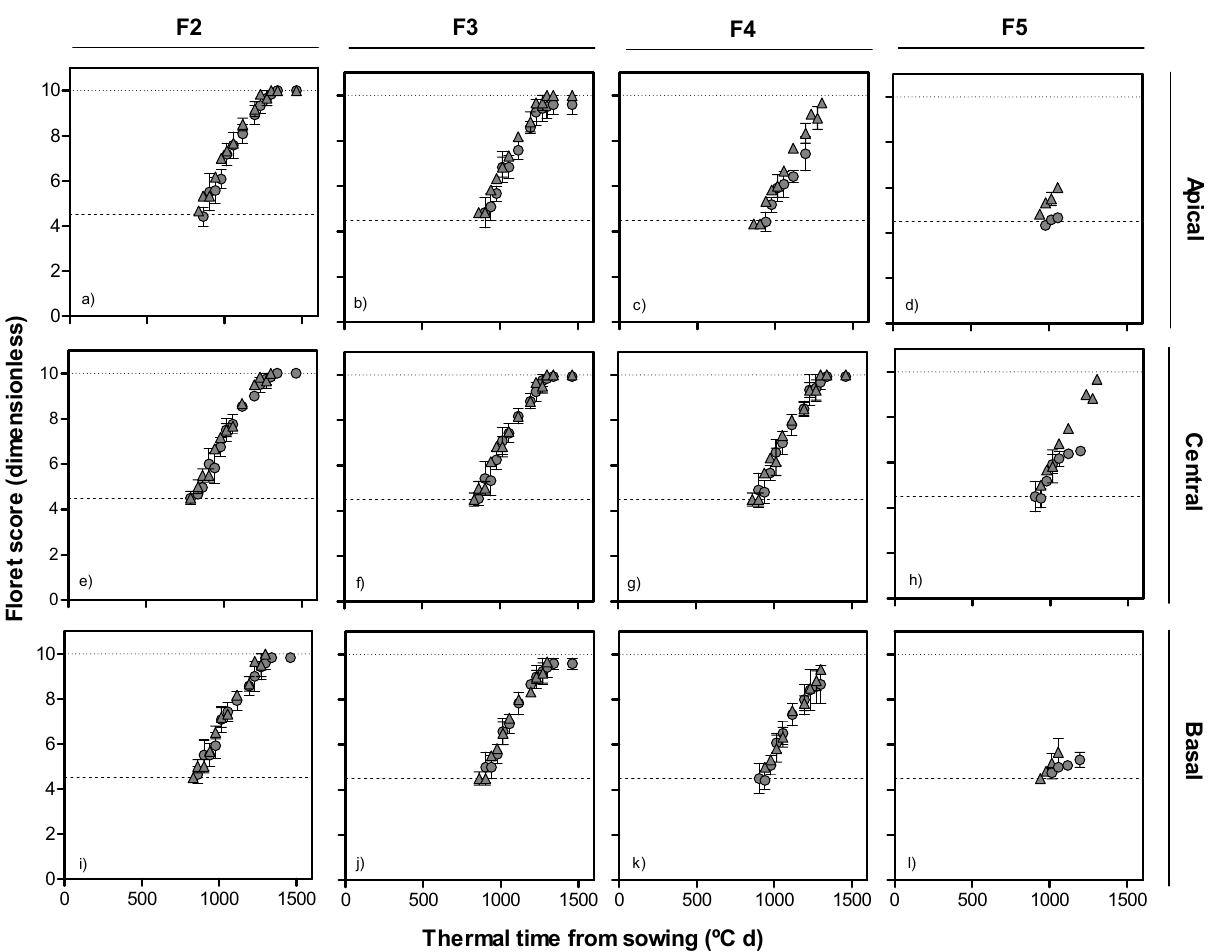
Figure 8. Dynamics of floret development (floret score) in F2, F3, F4 and F5 florets at apical (top panels: a – d ), central (middle panels: e – h ) and basal (bottom panels: i – l ) positions of spike with thermal time from sowing in lines with Eps-2B-late (triangles) and - early (circles) allele with Eps-7D-early allele in the background in first cropping